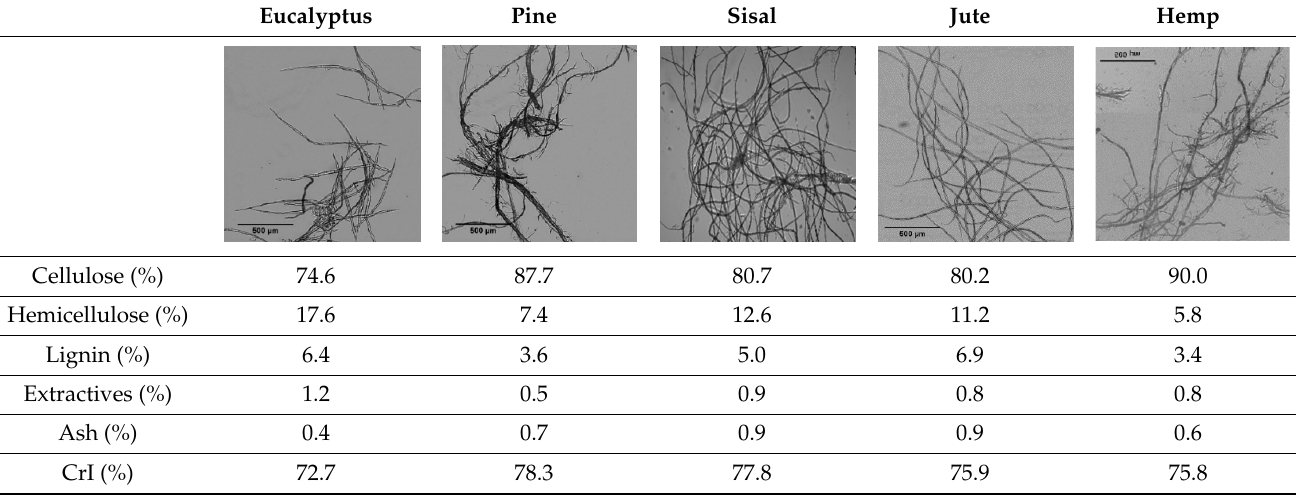
Table 1. Raw materials characterization: composition, crystallinity, and optical images (5 × magnification).